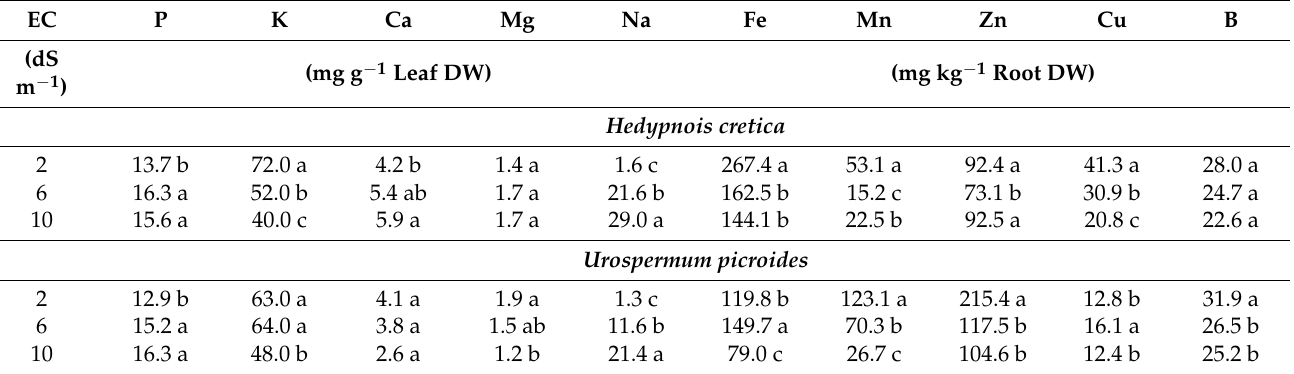
Table 4. Root nutrient concentrations at harvest date of Hedypnois cretica and Urospermum picroides plants grown under different nutrient solution EC levels (2, 6, and 10 dS m − 1